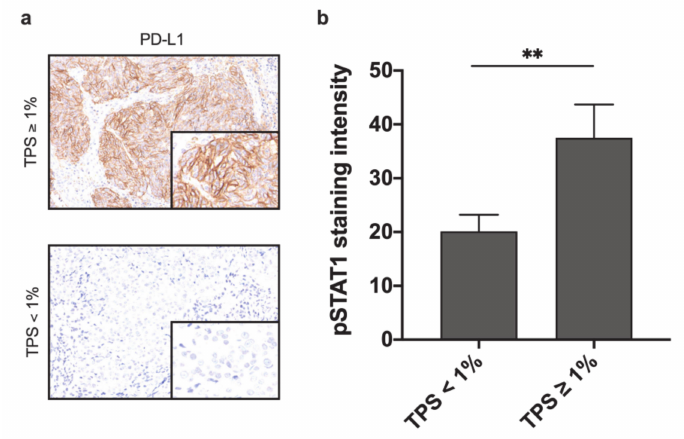
Figure 7. pSTAT1 expression is associated with PD-L1 expression in HNSCC local recurrence. ( a ) Representative images of tumors with TPS ≥ 1% and TPS < 1%. ( b ) Di ff erence in mean pSTAT1 expression in PD-L1 positive (TPS ≥ 1%) and negative (TPS < 1%) tumors. ** p <